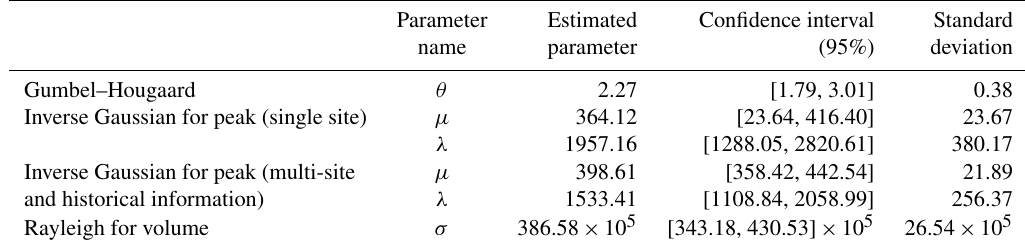
Table 2. Estimated parameters of the inferred distributions and their confidence interval